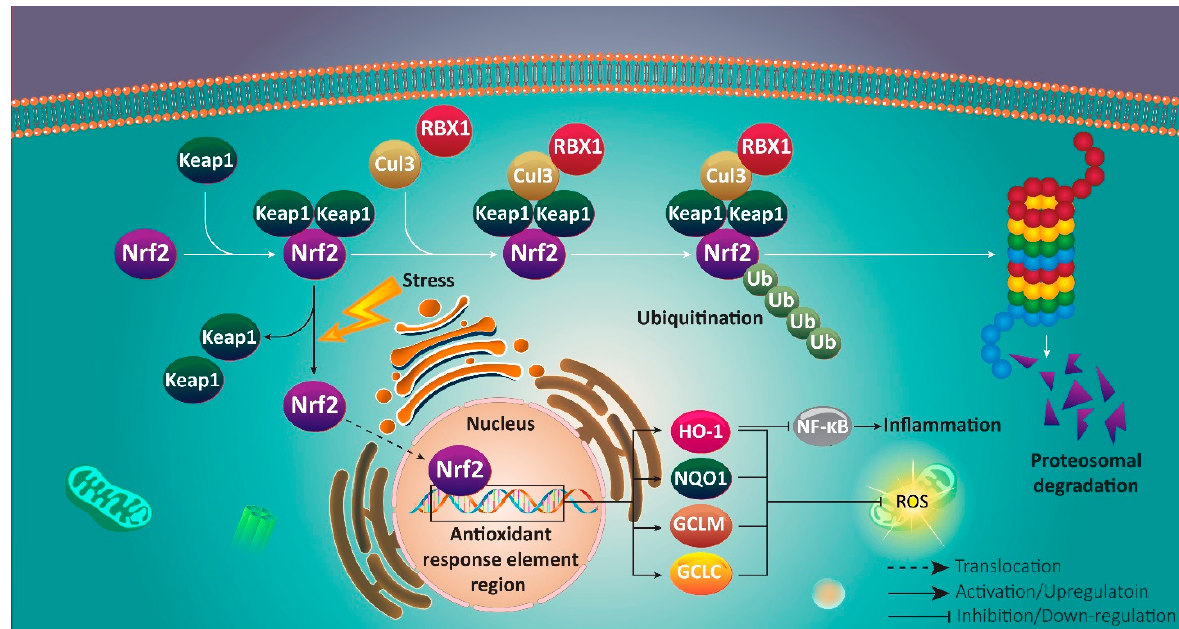
Figure 1. A schematic presentation of Nrf2 signaling pathway. Oxidative stress induces nuclear translocation of Nrf2 to promote antioxidant activity via up-regulating HO-1, NQO1, and GCLM.